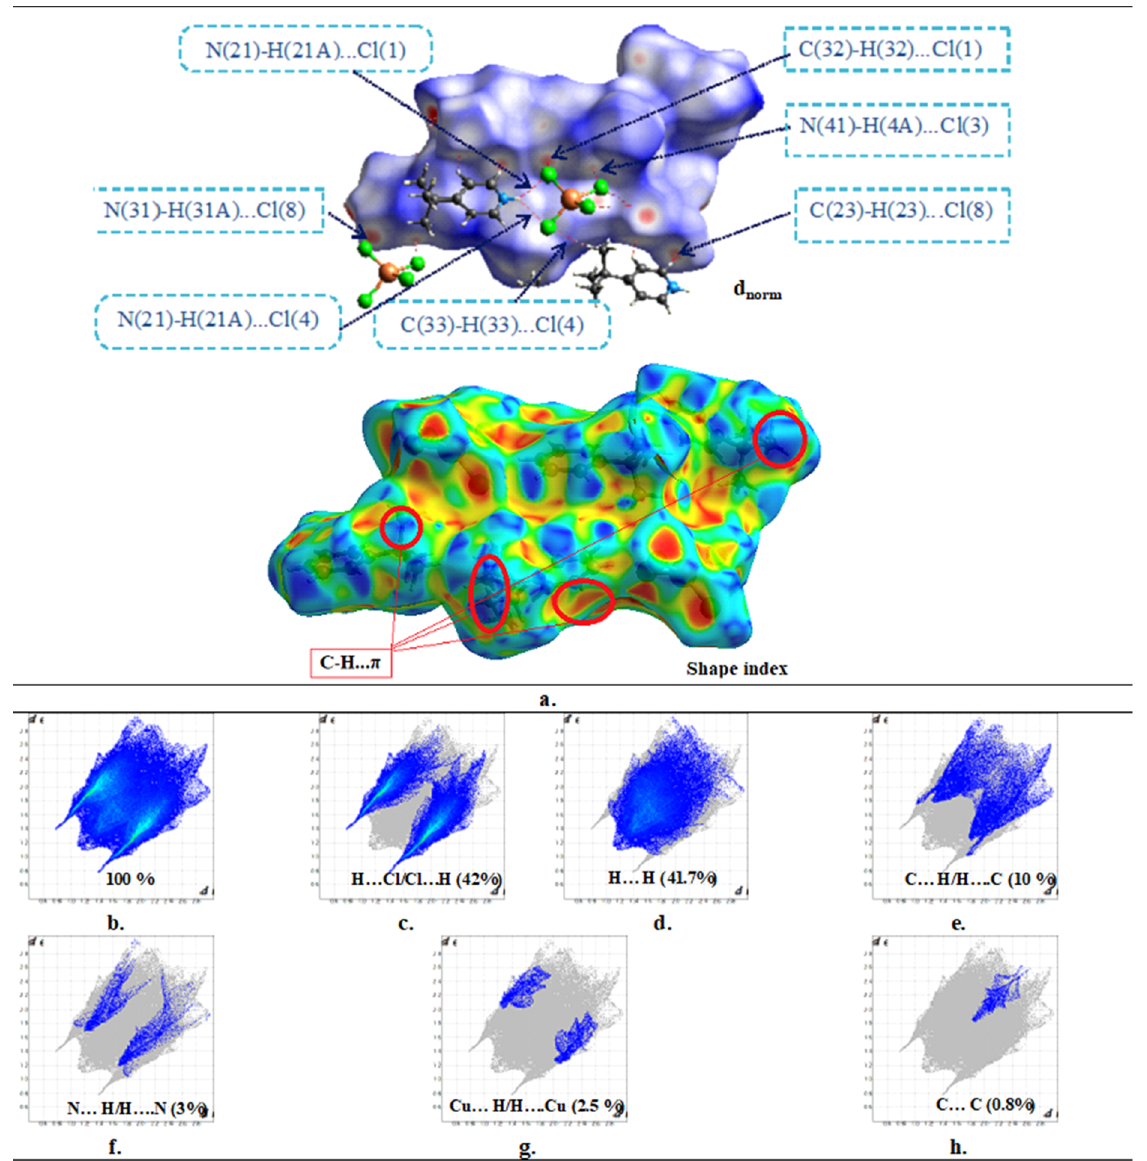
Figure 7. 2D plots showing the title compound’s principal interactions. Hirshfeld surface mapped with d norm and shape-index ( a ). Selected FP delineated into; 100% ( b ), H...Cl/Cl...H ( c ), H...H ( d ), C...H/H...C ( e ), N...H/H....N ( f ), Cu...H/H...Cu ( g ), and C…C ( h ).